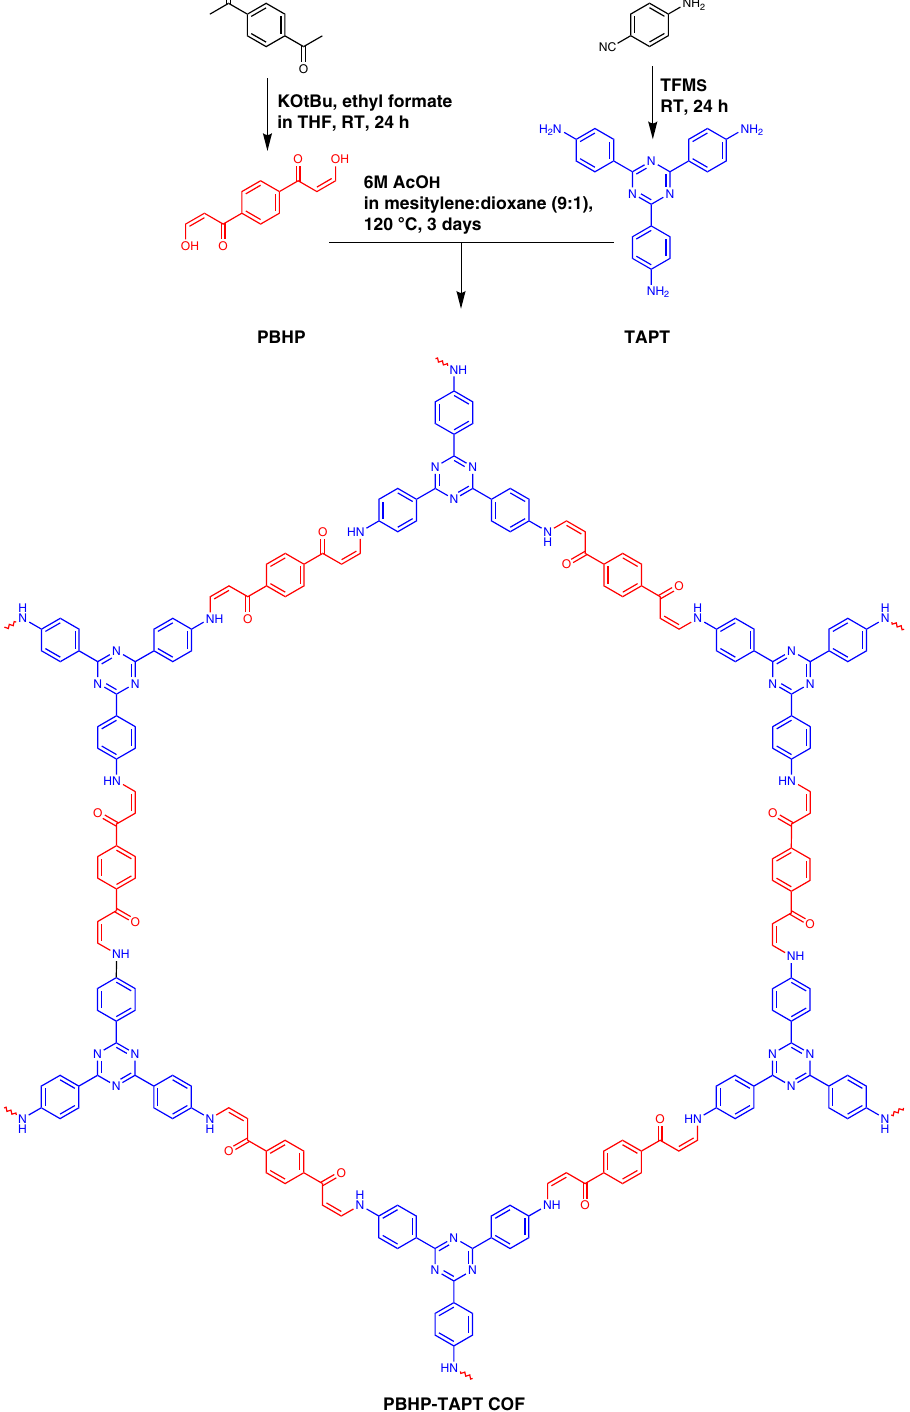
Fig. 1 Reaction scheme for PBHP-TAPT COF and its constituent building